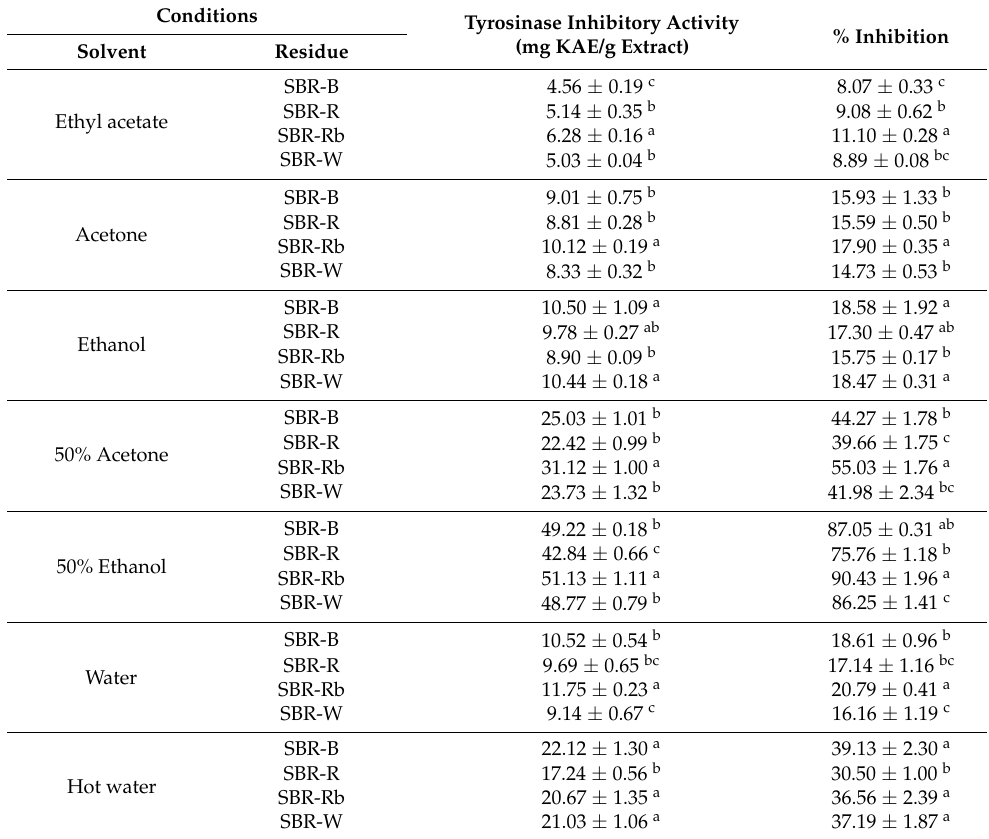
Table 4. Tyrosinase-inhibitory activity of crude extracts prepared from solid-based residues (SBRs) using different